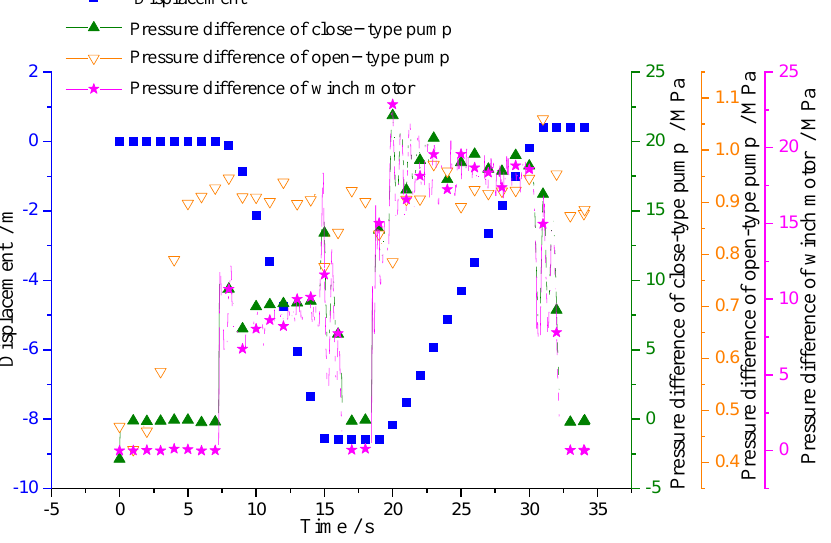
Figure 7. Winch operation characteristics under a working cycle.